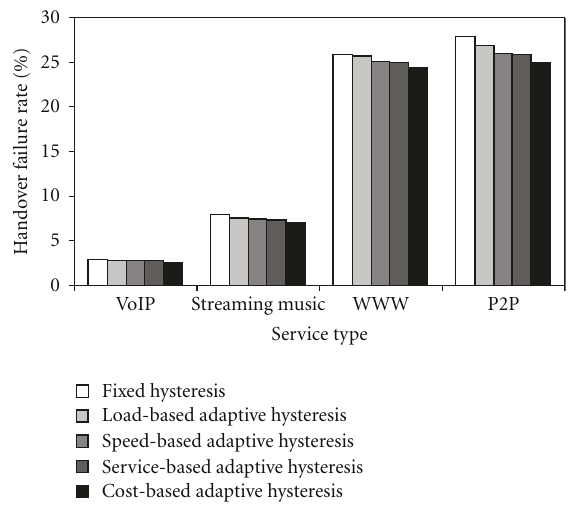
Figure 7: HFR per service type by the five hysteresis schemes when call arrival rate is fixed at